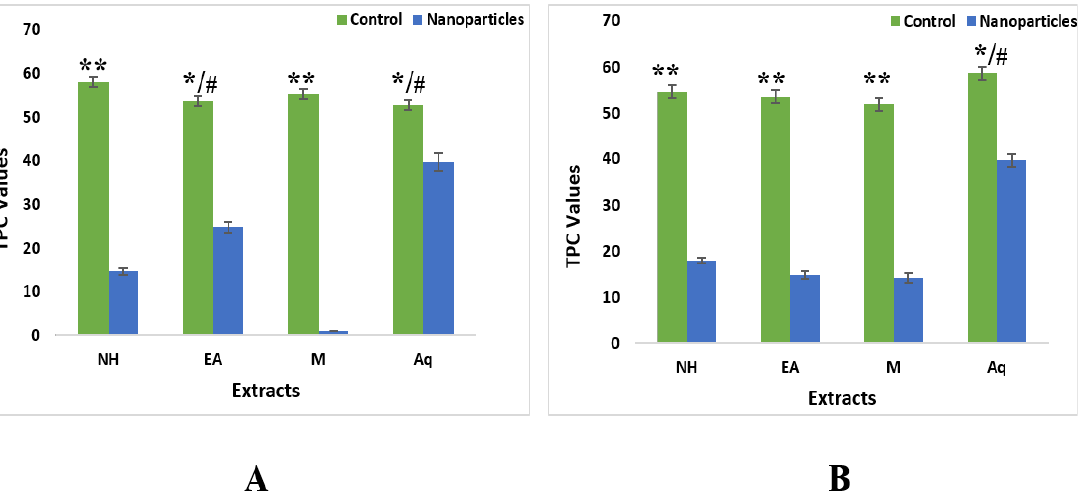
Figure 8. Total phenolic contents of nanoparticles and control extracts of W. somnifera from ( A ) Leaves ( B ) From Roots. Data are expressed as the mean ± SD. */# p < 0.05, ** p < 0.01.